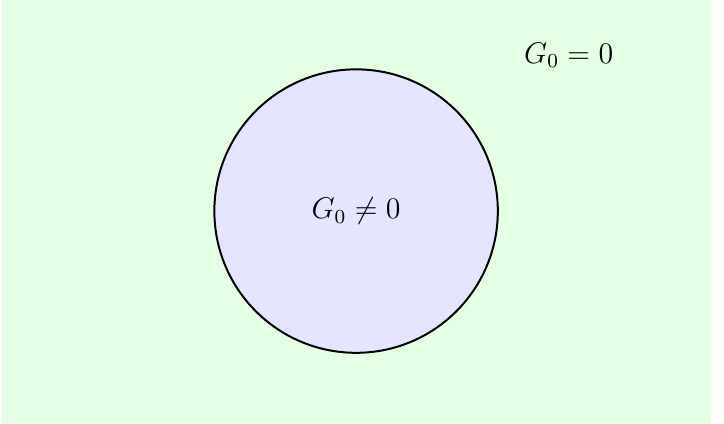
Figure 1 . Triple Chern-Simons terms mean that we must include into the path integral con(cid:12)gura- tions with a bubble in which G 0 6 = 0. Outside of the bubble, in the green area, (cid:30) (cid:24) (cid:30) + c leaves the action invariant, but in the blue area it does not. As a result, (cid:30) ! (cid:30) + c is no longer a